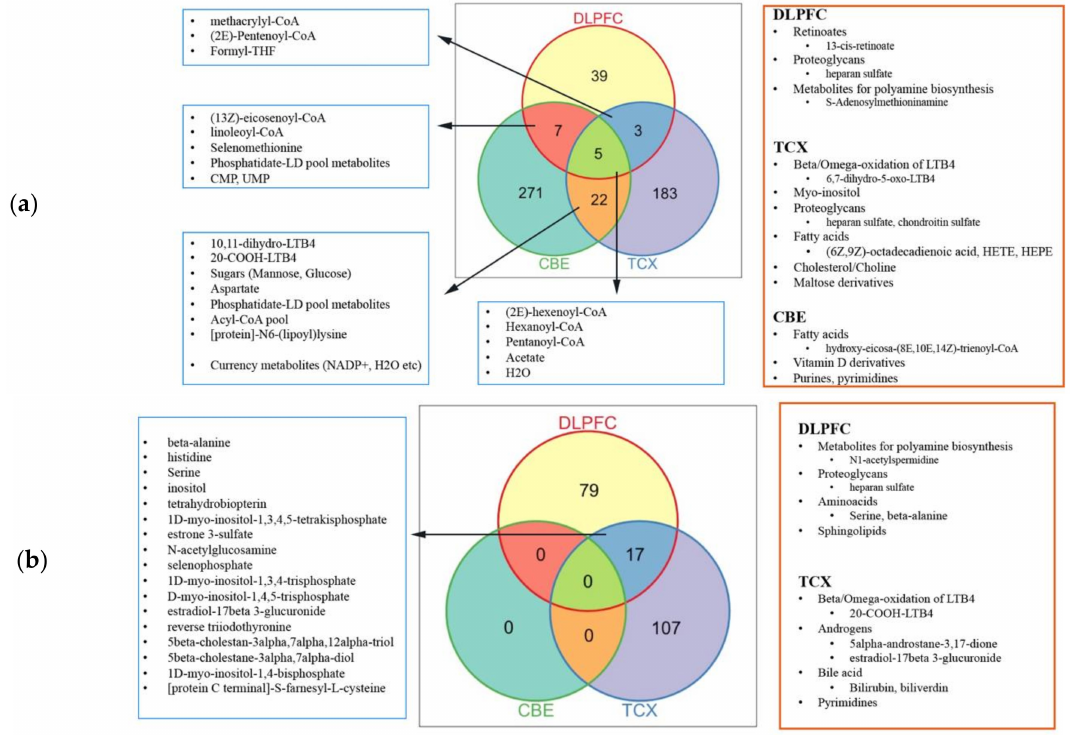
Figure 8. Reporter metabolites for: ( a ) down-regulated genes; and ( b ) up-regulated